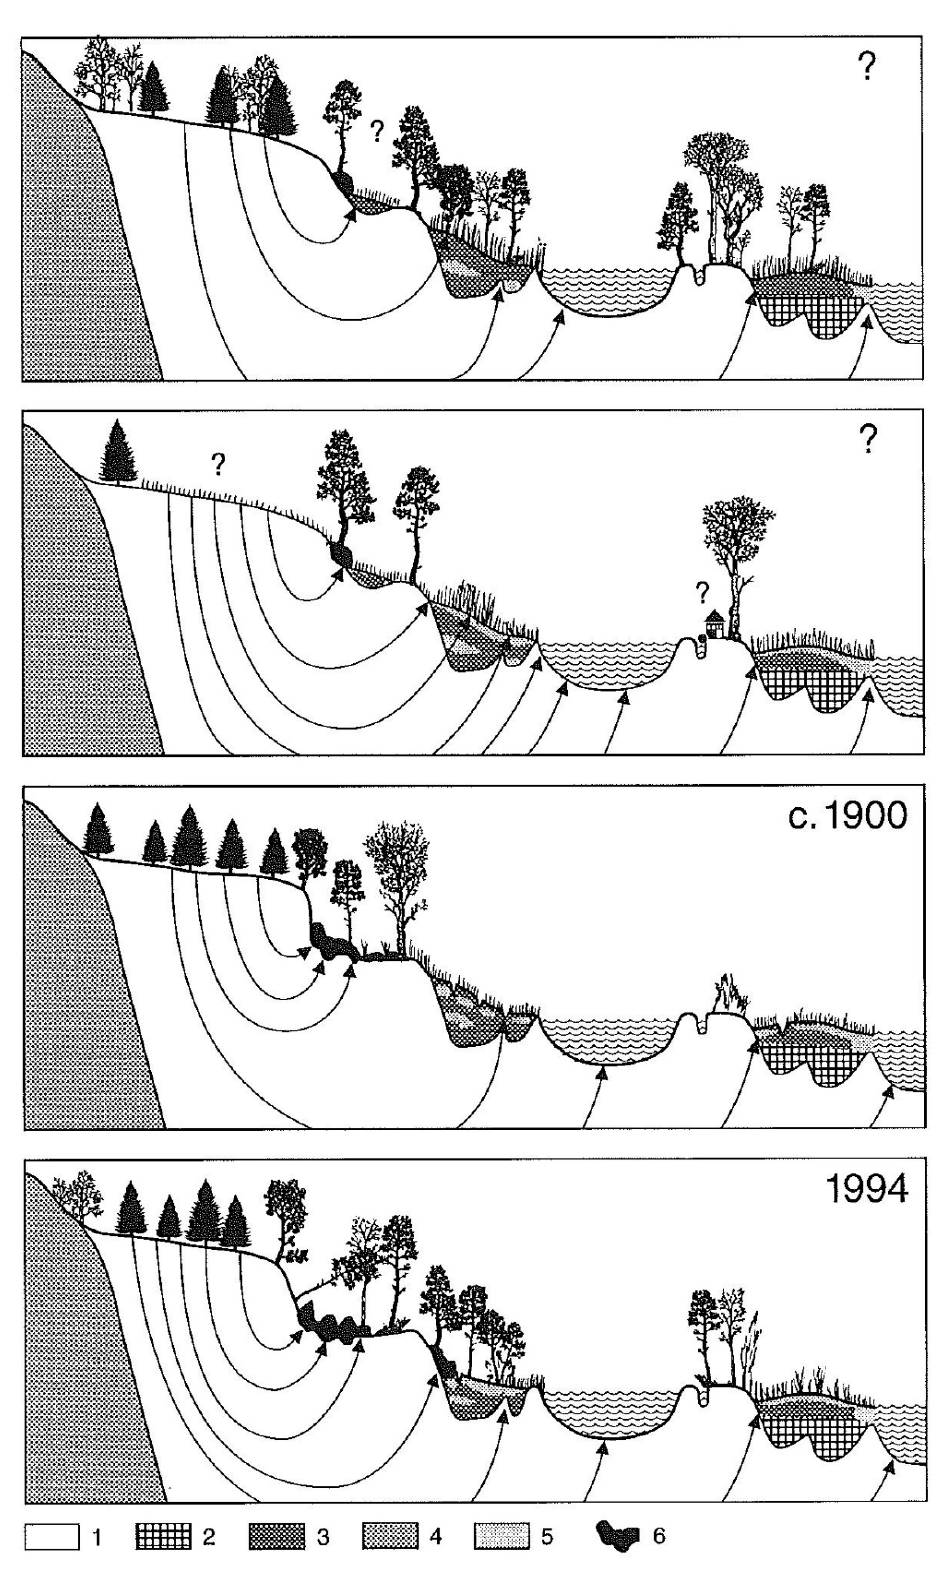
Figure 7. Extreme example of past erosion in spring systems is presented in the spring reserve Diabli Skok in North Poland (Grootjans et al . 1999). The four cross-sections are a sequence in time. Erosion was triggered by lowering lake levels downstream, which caused increased groundwater flow and erosion upstream and drying out of spring mires in the centre of the hydrological gradient. Arrowed lines are inferred flows of groundwater. Numbered boxes: 1 = outwash plain (sand), 2 = lake chalk, 3 = tall sedge peat with wood, 4 = front moraine, 5 = sedge peat without wood, 6 = spring